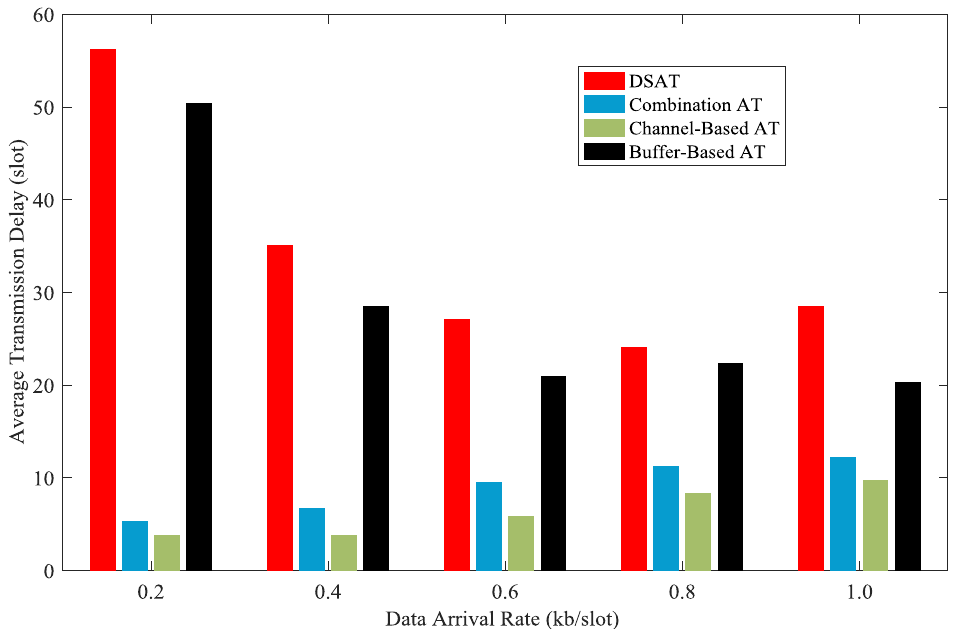
Figure 27. Average transmission delay for comparative strategies (Data